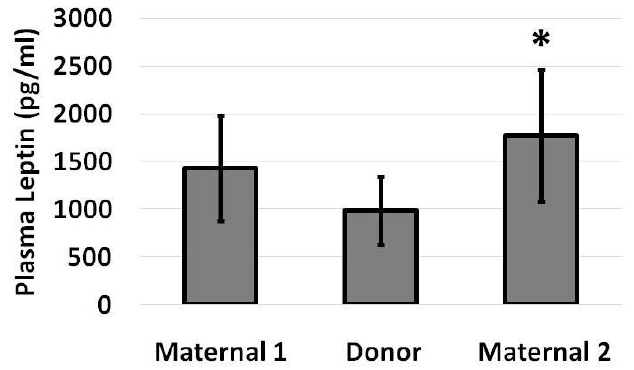
Figure 2. Plasma leptin levels among infants at the end of a week of maternal milk, an intervening week of donor milk and a final week of maternal milk. Leptin levels increased on conversion from donor milk back to maternal milk. Data are presented as mean (SD) with N = 8 and * p < 0.05 for Maternal 2 versus Donor.